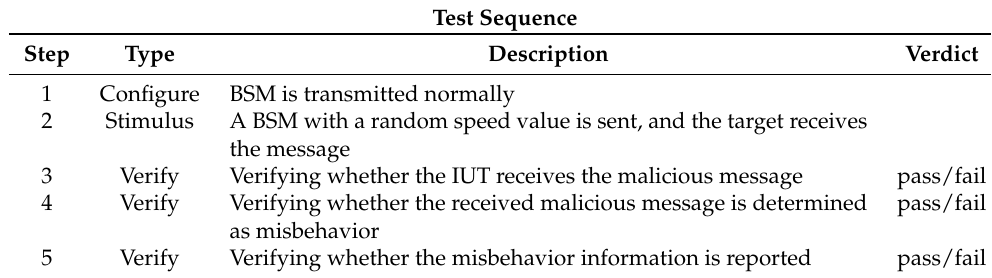
Table 7. Test sequence of Evaluation Scenario